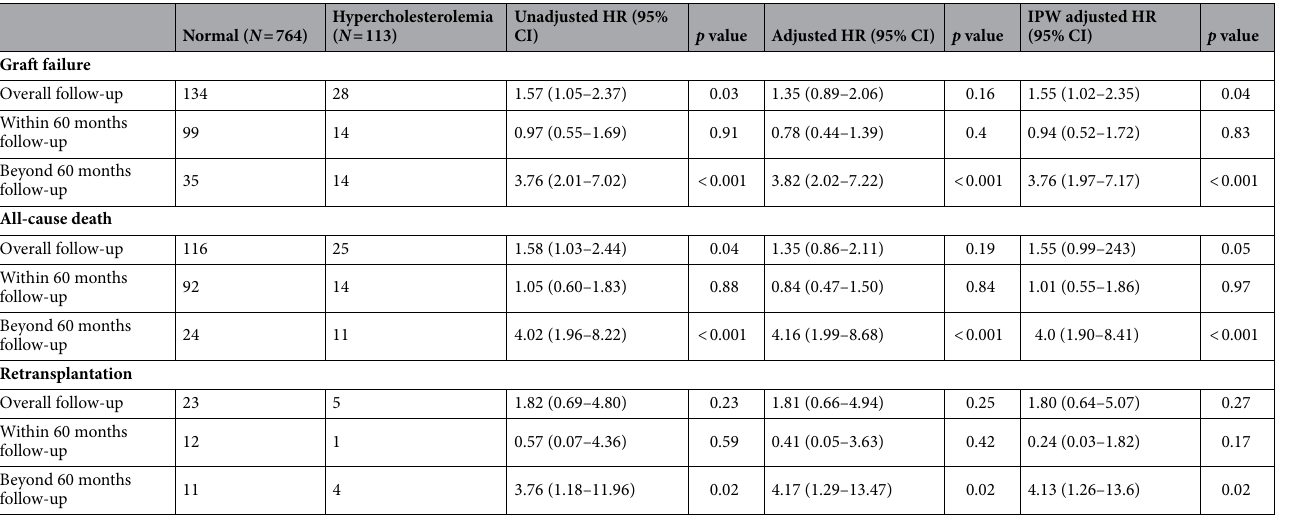
Table 3. Graft-related endpoints. Values are n (%), All cause death is based on a Cox regression, while the others are based on the competing risk analysis. Covariates include male, age, hypertension, diabetes, tuberculosis, stroke, hepatocellular carcinoma, acute hepatic failure, and mTOR-based immunosuppression. Biliary complication was compared only for the overall follow-up considering that proportional hazard assumption was not violated. MACE major adverse cardiac event, HR hazard ratio, IPW inverse probability